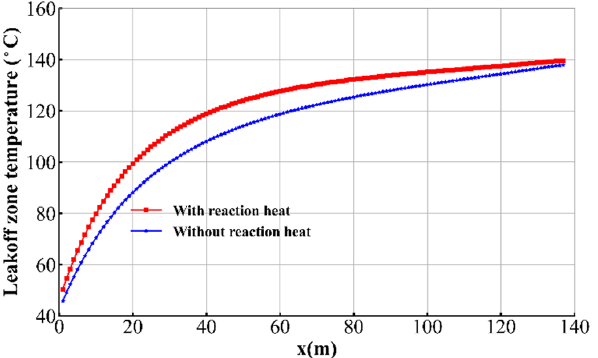
Figure 4. Temperature distribution of the leak-off zone (blue line: without reaction heat; red line: considering reaction heat).